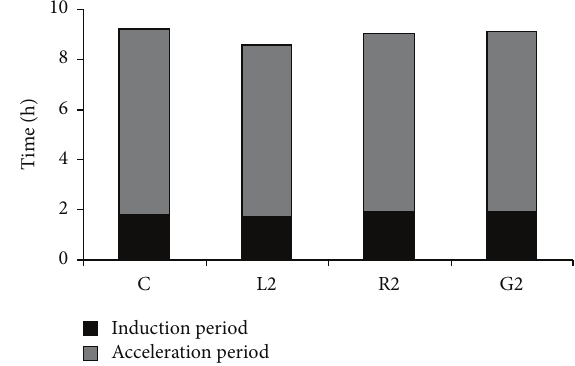
Figure 6: Induction period and acceleration period of the cementi- tious